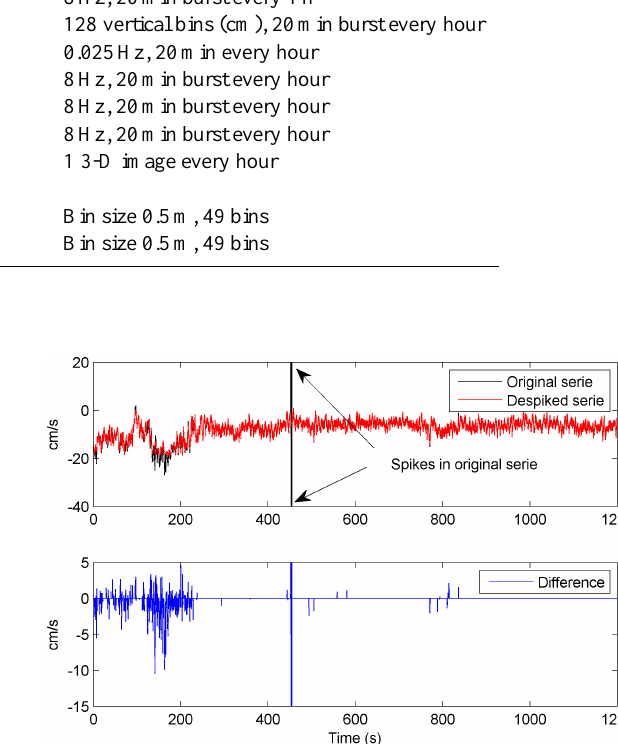
Figure 3. Top: Example of original and despiked ADV time se- ries. Bottom: di ff erence between the series shown in the top panel. Horizontal axis shows time, sampling frequency was of